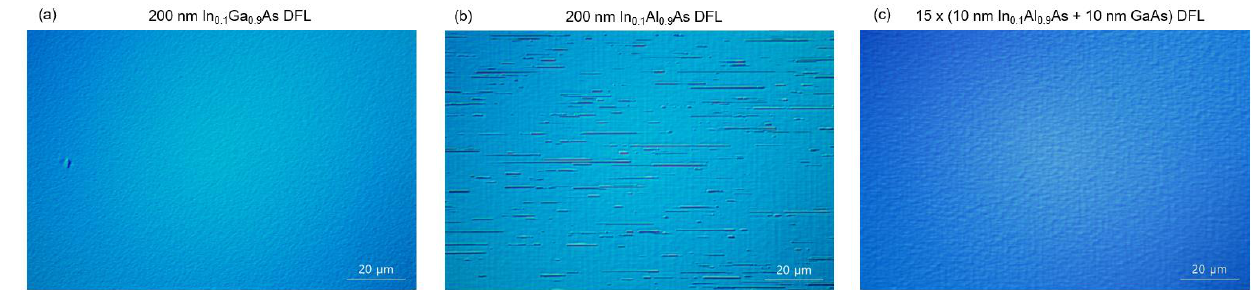
Figure 2. Optical microscope images of GaAs/Si buffer surface with ( a ) n-In 0.1 Ga 0.9 As DFL, ( b ) n- In 0.1 Al 0.9 As DFL and ( c ) n-In 0.1 Al 0.9 As/n-GaAs DFL.